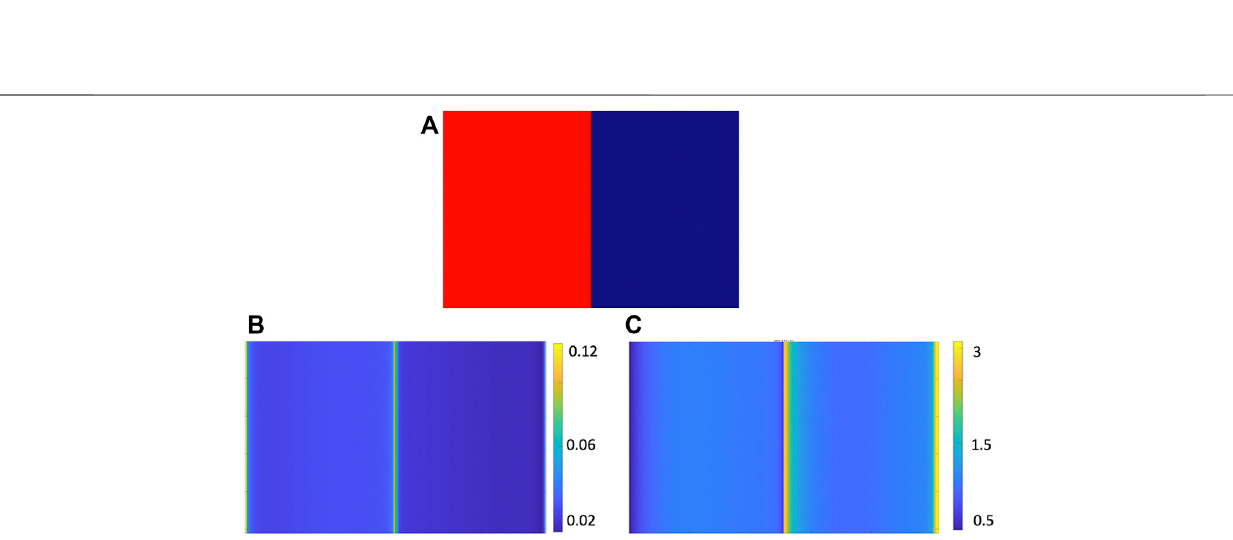
Frontiers in Signal Processing |